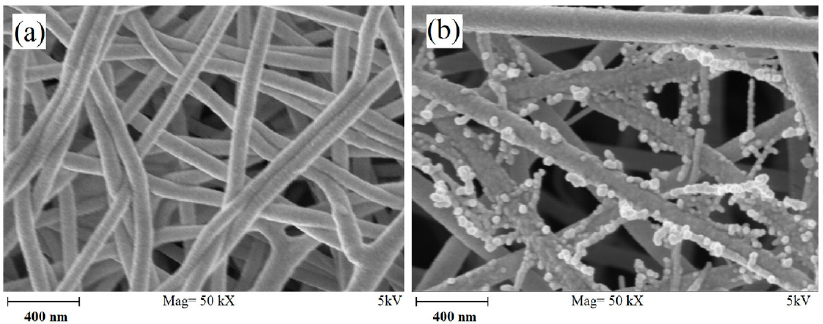
Figure 2. FESEM images of ( a ) electrospun PA6 nanofibers (NFs); and ( b ) decorated by hydroxyapatite (HA) nanoparticles via electrospinning method. Reprinted with permission from Ref. [16]. Copyright © 2015 Published by Elsevier B.V.